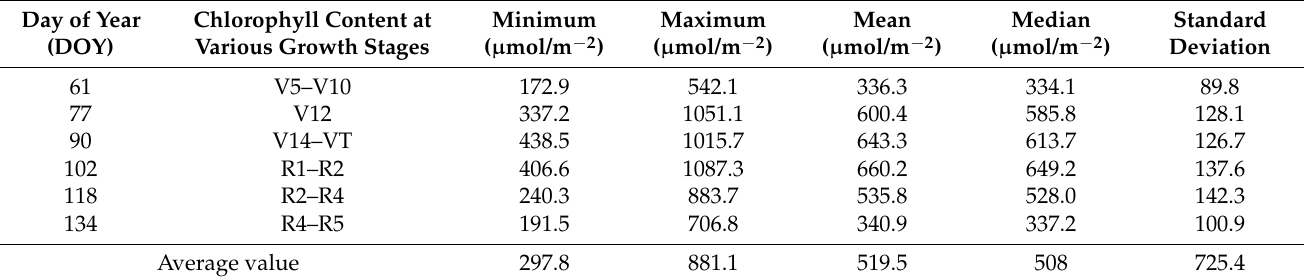
Table 5. Descriptive statistics of maize chlorophyll content throughout the various growth stages.